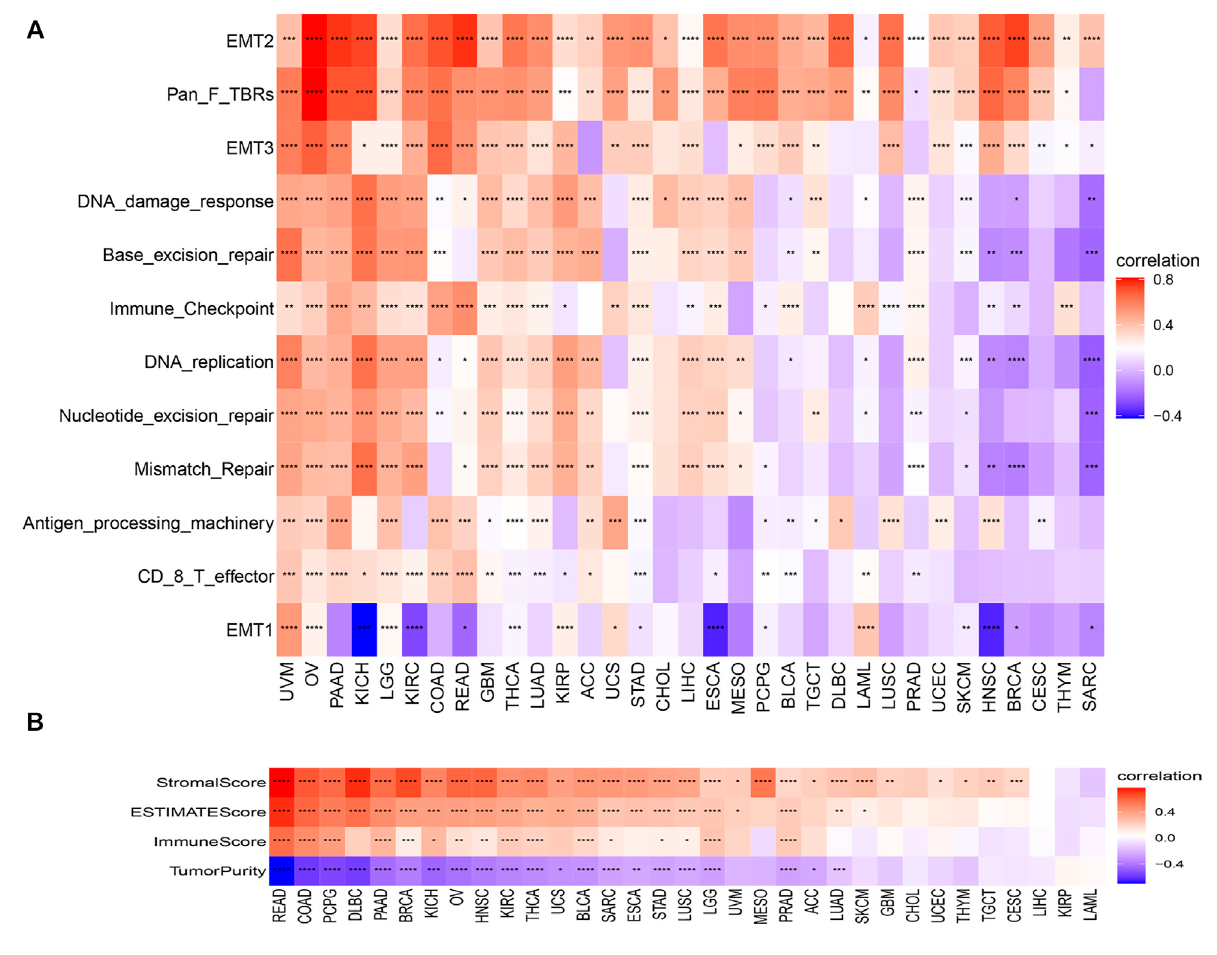
Frontiers in Pharmacology |